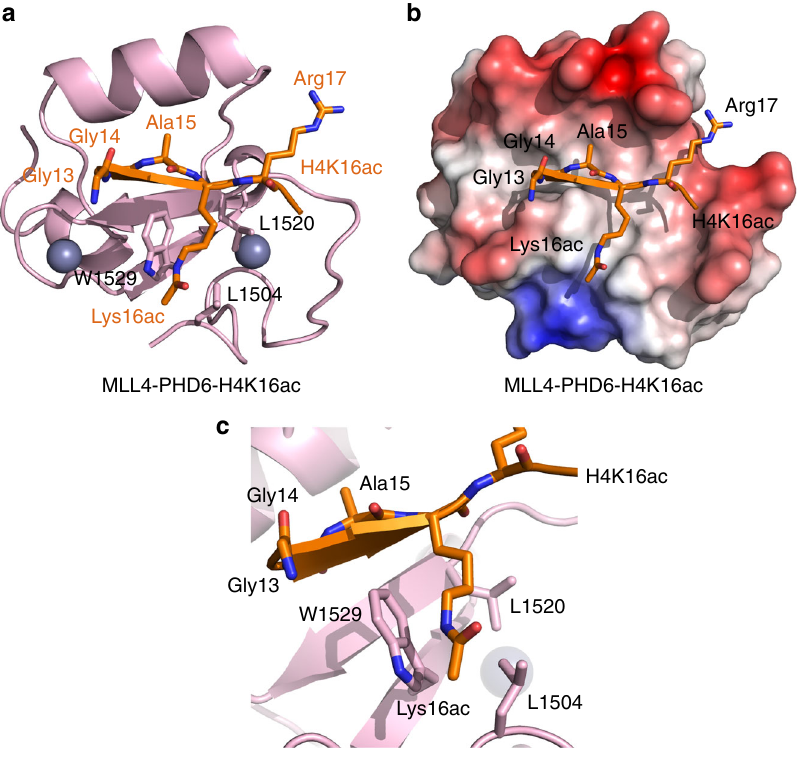
Fig. 2 Structure of MLL4-PHD6 in complex with H4K16ac peptide. a A ribbon diagram of the solution nuclear magnetic resonance structure of MLL4-PHD6 (pink) in complex with the H4K16ac peptide (orange). b Electrostatic surface potential of MLL4-PHD6 colored blue and red for positive and negative charges, respectively. The bound H4K16ac peptide is shown in a stick model. c A zoom-in view of the H4K16ac-binding